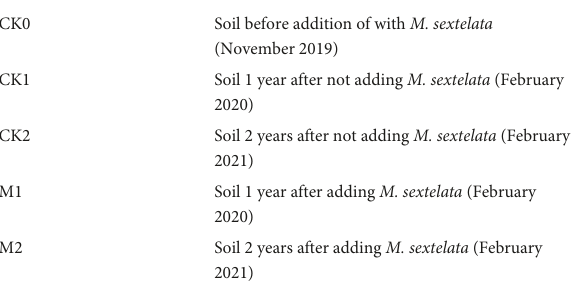
TABLE 1 Soil sample abbreviations and